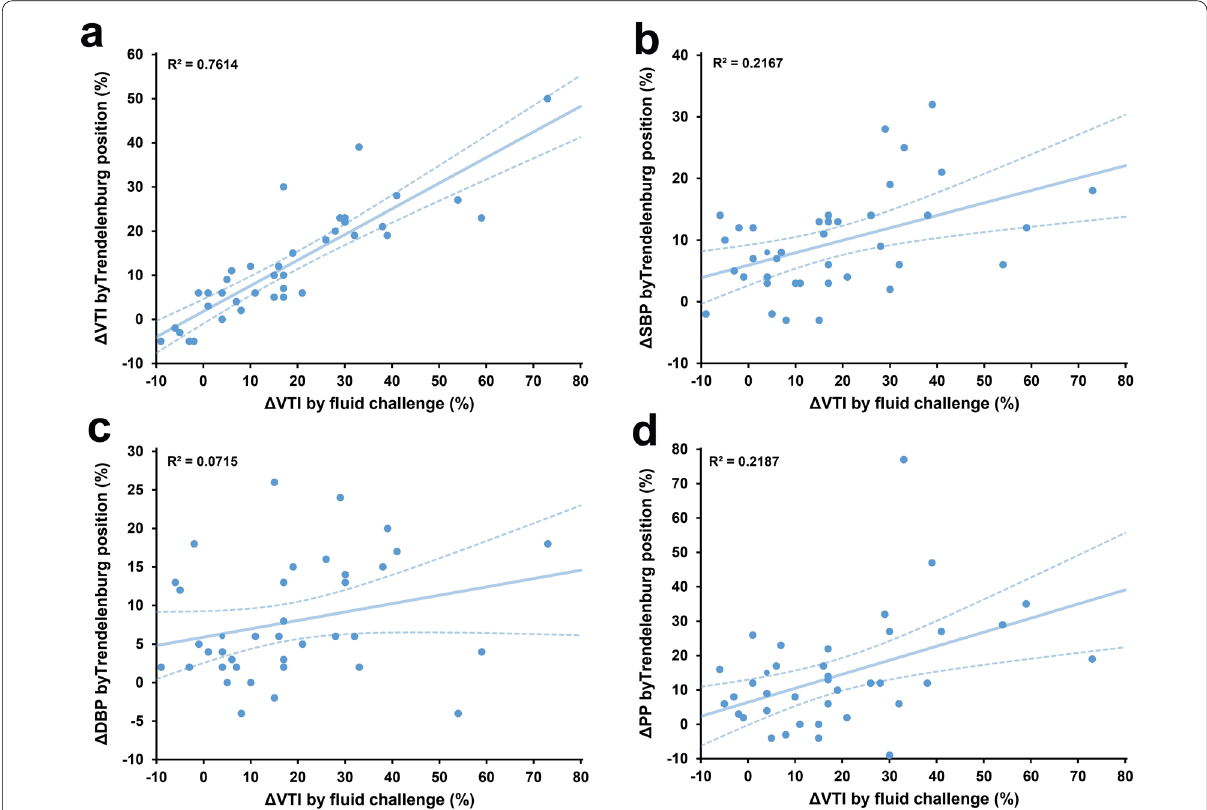
Fig. 2 Linear regression between changes in velocity–time integral (ΔVTI, a ), systolic blood pressure (ΔSBP, b ), diastolic blood pressure (ΔDBP, c ) and pulse pressure (ΔPP, d ) induced by the Trendelenburg position and the fluid challenge. Solid and dashed lines indicate regression lines and their 95% confidential